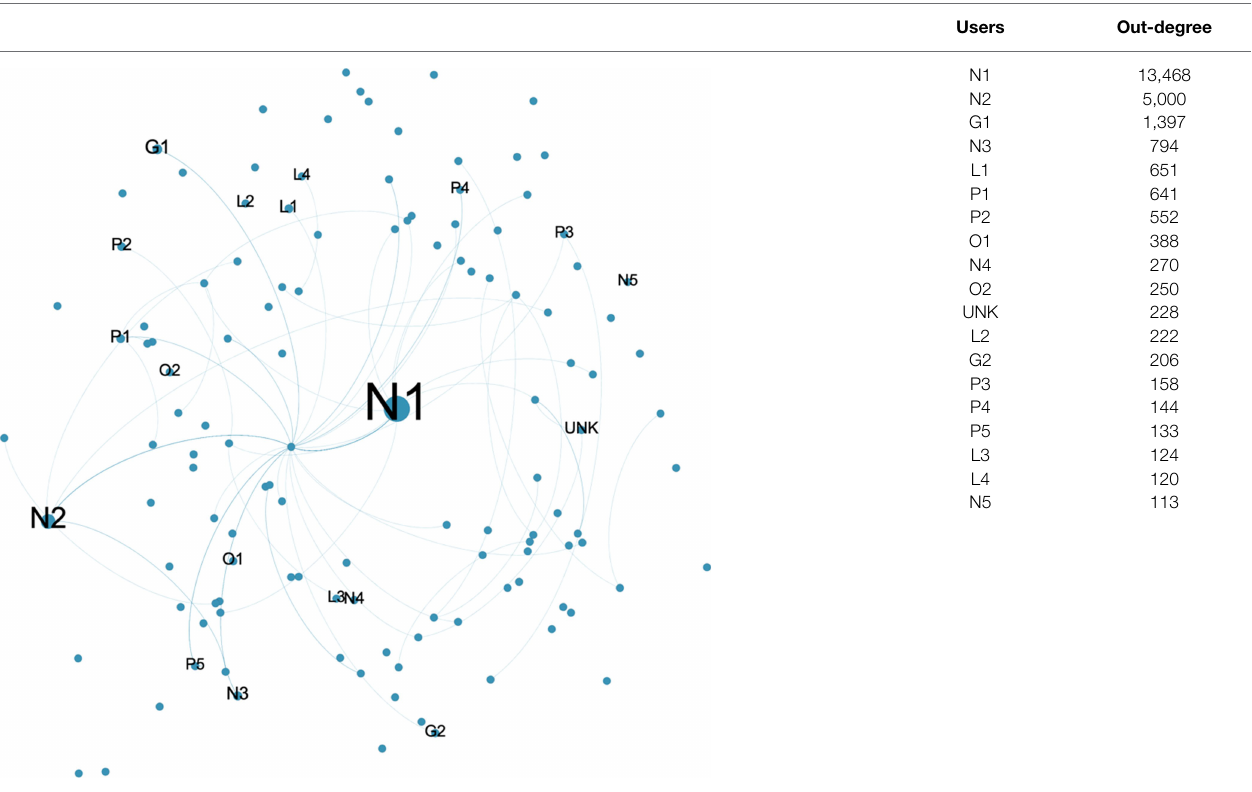
TABLE 5 | Users with out-degrees greater than